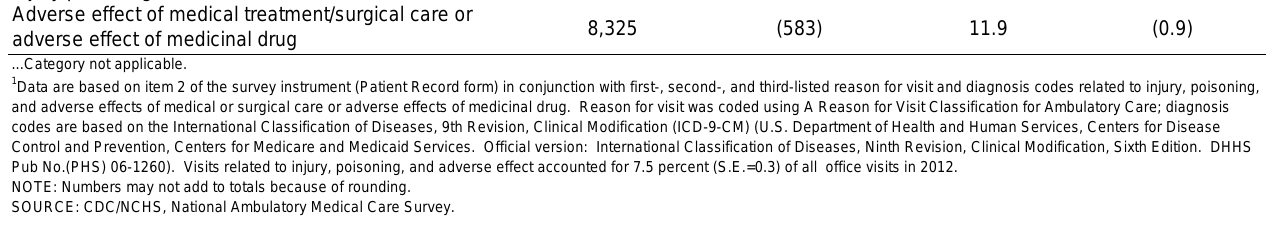
All visits related to injury, poisoning, and adverse effect 1